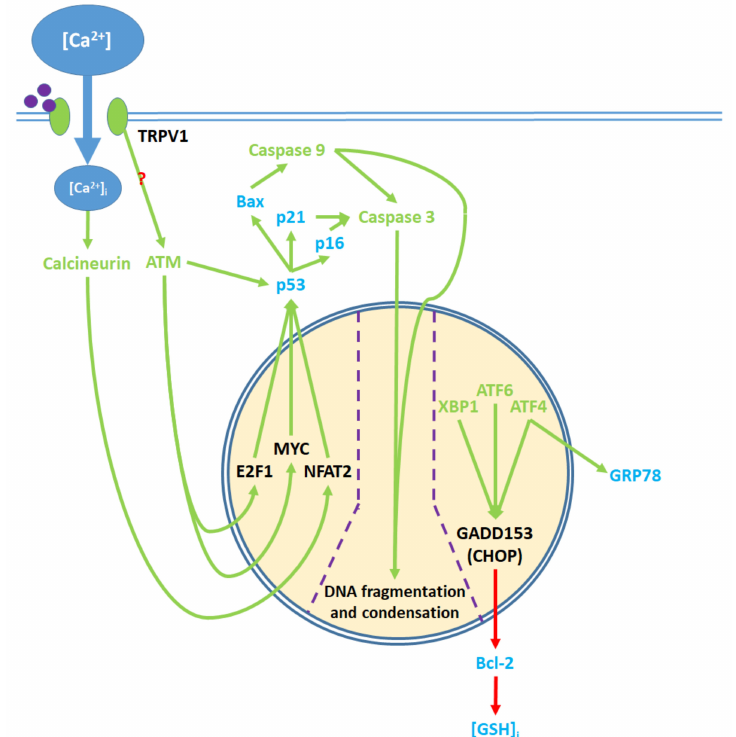
Figure 5. Pro-apoptotic processes induced by TRPV1 localized in the nucleus. The nuclear component of ER stress occurs as ATF4, ATF6, and XBP1 are activated by ER stress and upregulate GADD153, which in turn downregulates Bcl-2 protein production. The upregulation of GRP78 by ATF4 feeds back to and enhances ER stress. The cytosolic activation of the ATM serine-threonine kinase by TRPV1 protein signaling and calcineurin by elevated [Ca 2 + ] i promote the nuclear transcription factors E2F1, MYC, and NFAT2, which upregulate p53. The precise mechanism through which TRPV1 activates ATM remains unclear. p53 upregulates the apoptotic mediators Bax, p16, and p21, which activate caspase 9 and 3. Activated caspases translocate from the cytosol to the nucleus, where they mediate DNA fragmentation and